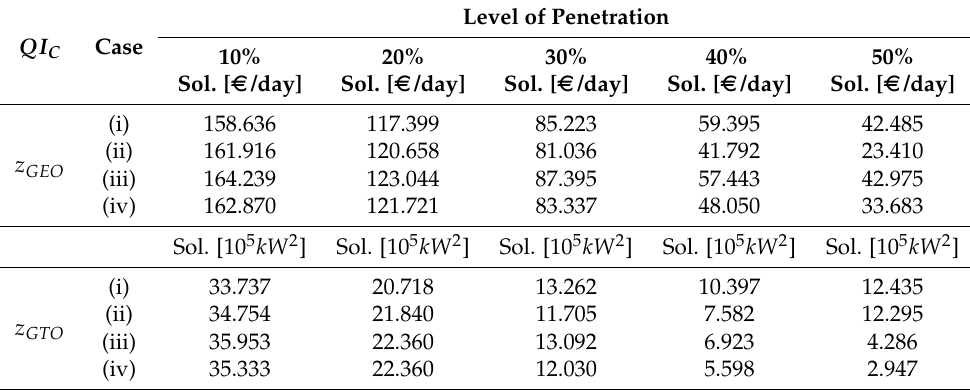
Table 22. Summary of objective function